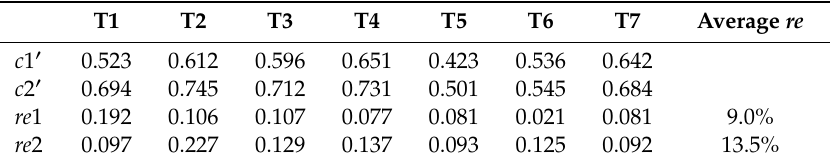
Table 4. Calculated insulator structure coe ffi